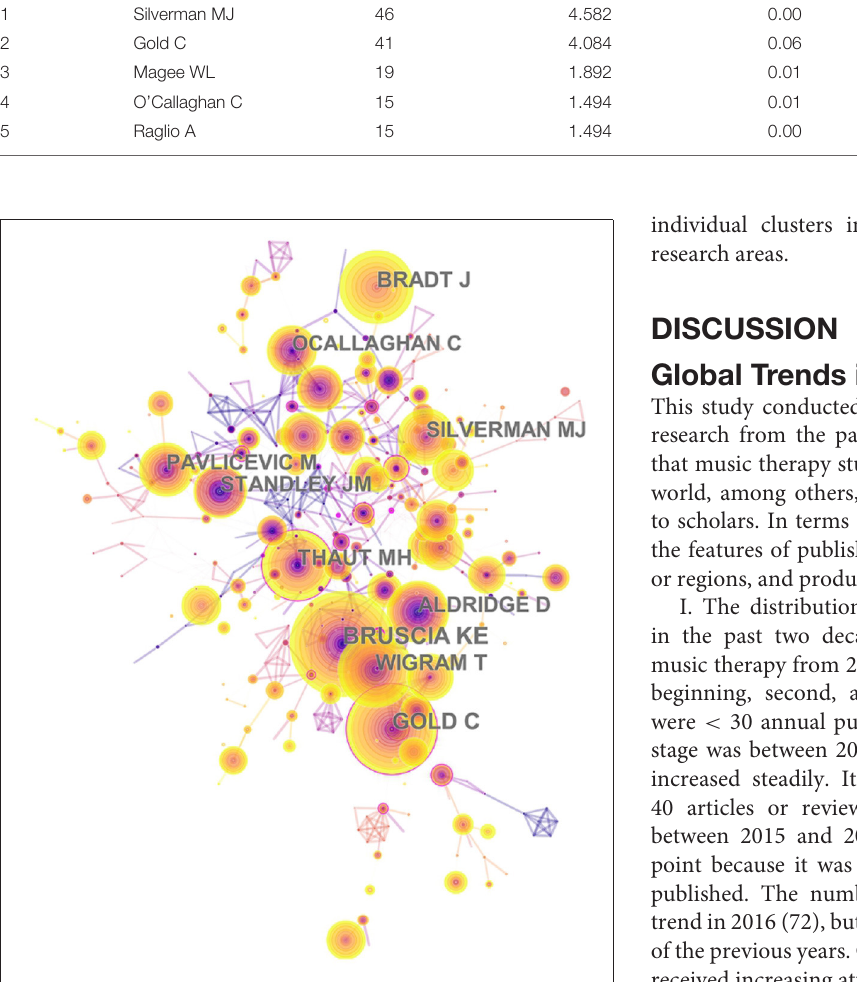
FIGURE 7 | The network of author co-citaion. In this map, the node represents an author, and the link represents the co-citation frequency between two authors. A larger node represents more publications of the author. A thicker purple circle represents greater influence in this